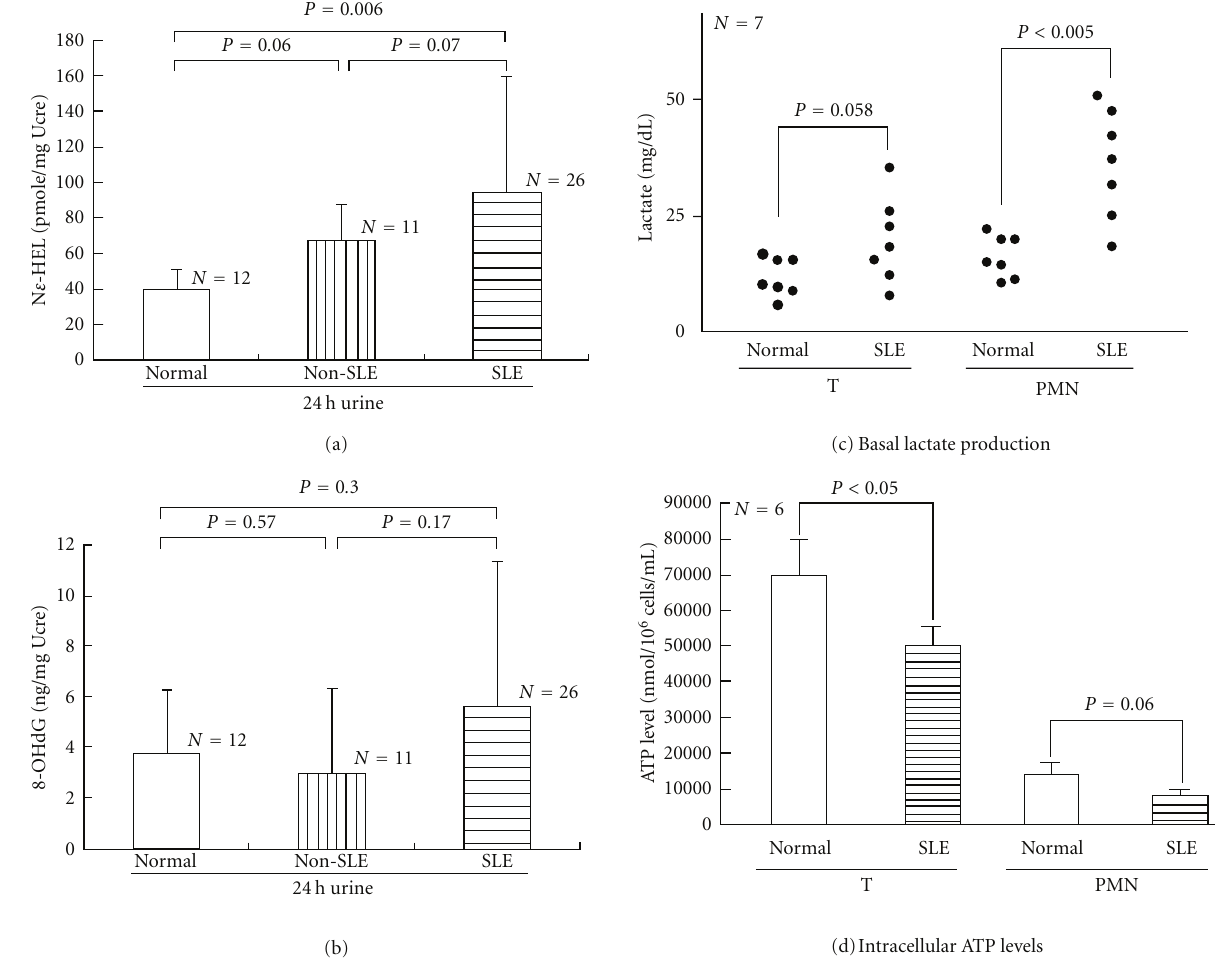
Figure 1: Comparison of 24-hour urinary excretion of N -benzoyl-glycyl- N ε -(hexanoyl)lysine ( N ε -HEL) and 8-hydroxy-2-deoxyguanosine (8-OHdG), intracellular basal lactate levels, and ATP production of T lymphocytes and PMN from normal individuals, non-SLE patients, and patients with active SLE. (a) Urinary N ε -HEL excretion denoted by pmole/mg urine creatinine (Ucre). (b) Urinary 8-OHdG excretion denoted by ng/mg Ucre. (c) Intracellular basal lactate levels. (d) ATP production.